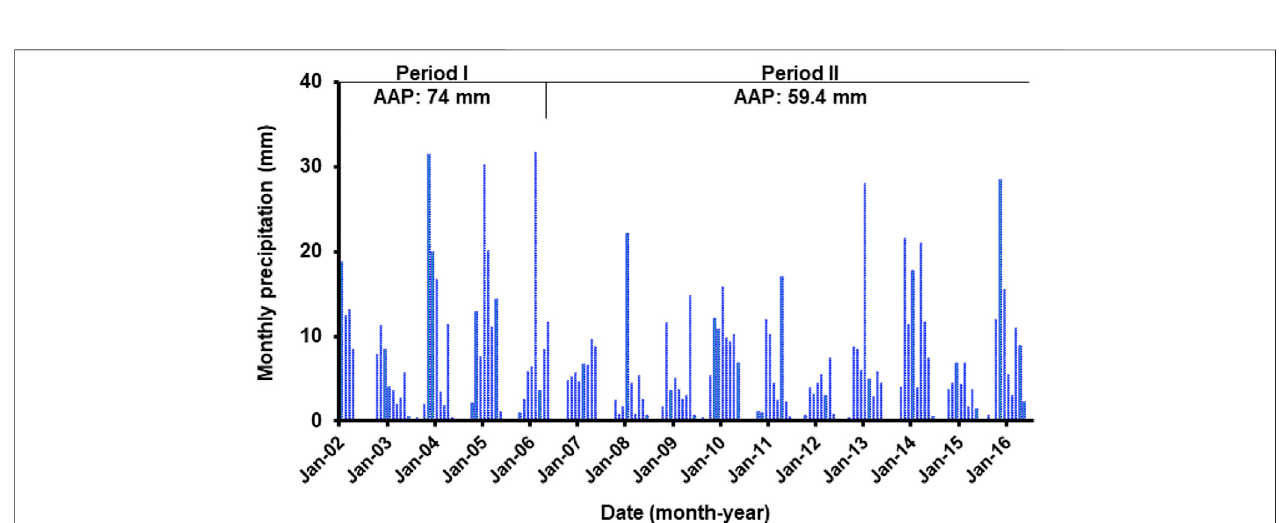
FIGURE 5 | Monthly precipitation (mm) over the Saq aquifer throughout the two